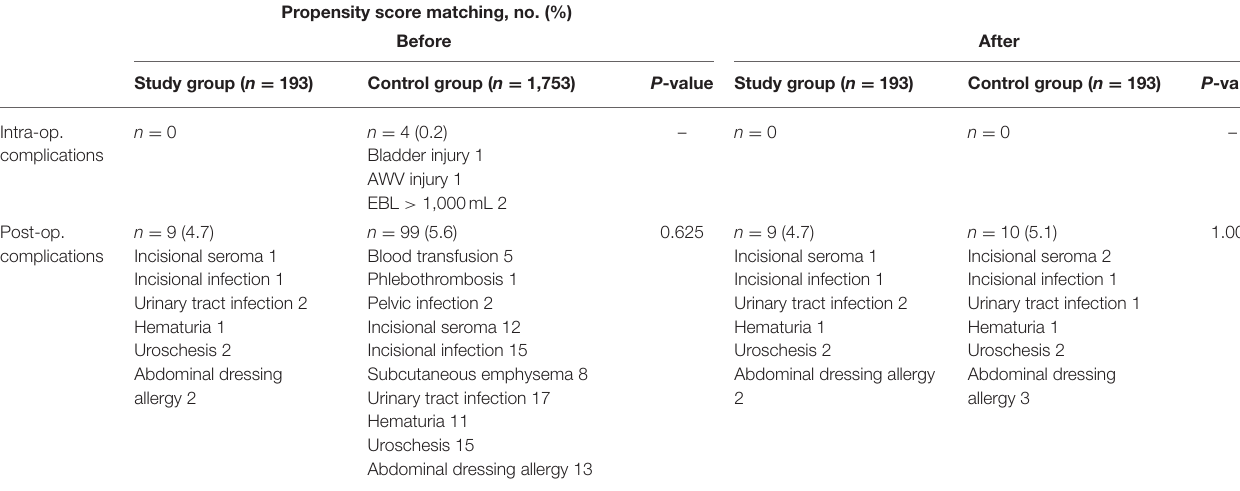
TABLE 3 | Peri-operation complications of the two groups. Propensity score matching, no. (%) Before After Study group ( n = 193)